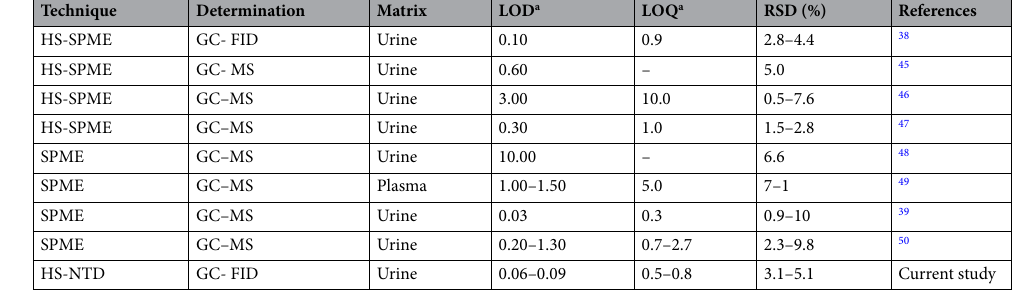
Table 2. Comparison of Zr-UiO-66-PDC@NTD with other techniques for determination of amphetamine compounds. a ng mL −1 . HS, headspace; SPME, solid-phase micro-extraction; NTD, needle trap device; GC, gas chromatography; FID, flame ionization detector; MS, mass spectrometry; LOD, limit of detection; LOQ, limit of quantification; RSD, relative standard deviation.